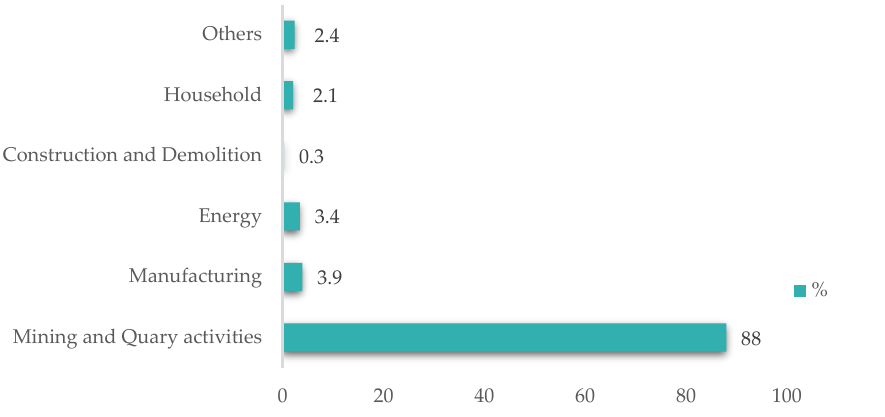
Figure 2. Percent of waste by types of activities in Romania, 2018 [16] .